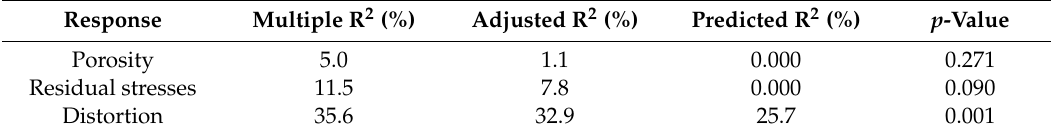
Table 5. Statistical analysis of the effect of energy density on SLM outcomes.